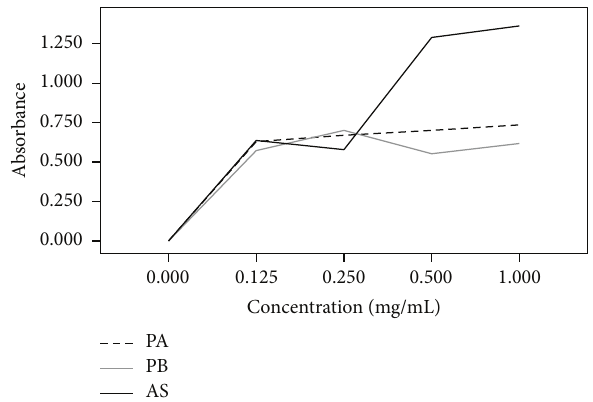
Figure 3: Reducing power activity of the phenothiazine derivatives compared to